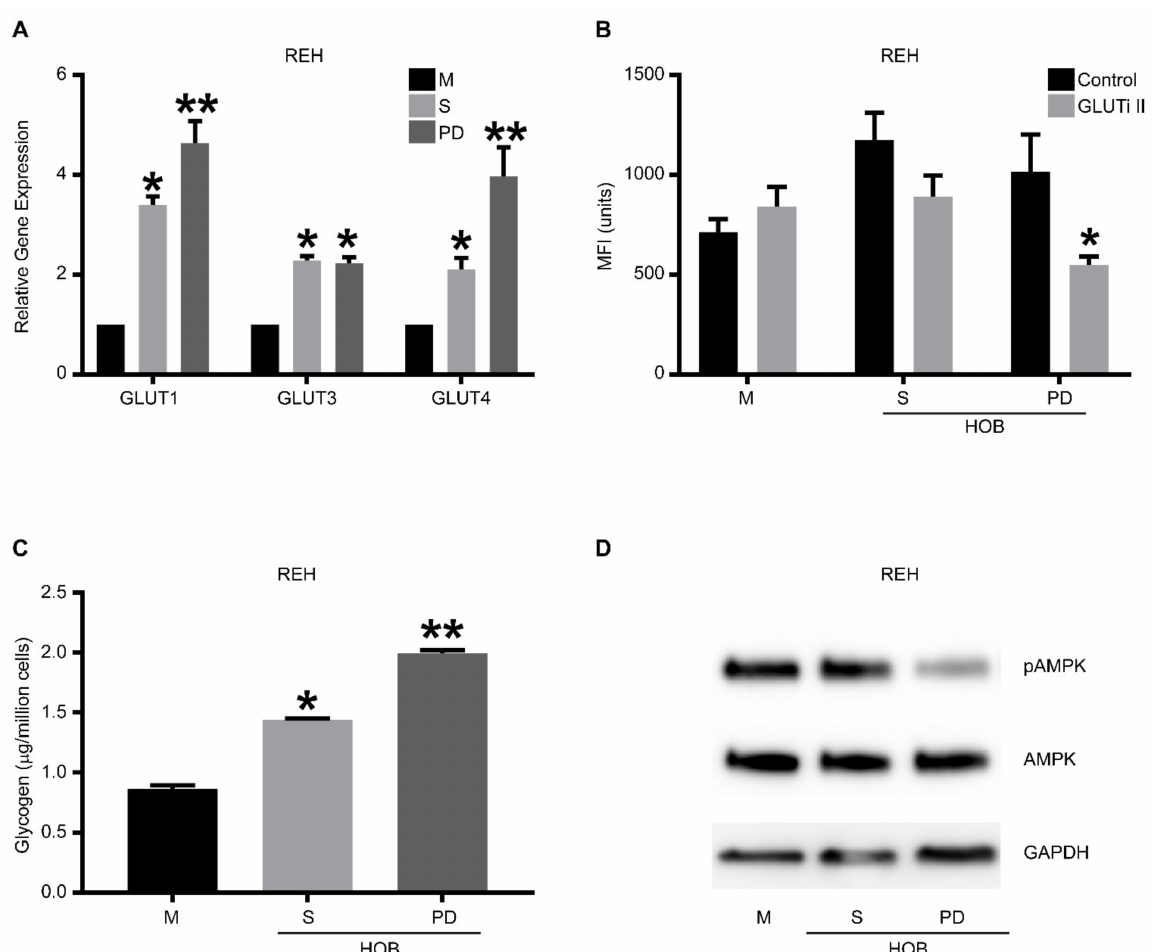
Figure 2. Drug-resistant phase dim (PD) cells are characterized by anabolic metabolism. REH cells were co-cultured with HOB, and the tumor cells in suspension (S) and the phase dim (PD) cells were isolated and compared to REH cells grown in media alone (M). ( A ) RT-PCR was used to determine the expression levels of GLUT-1, 3, and 4. Data is represented as mean ± SEM and is a representative of an experiment performed in triplicate at least two independent times. ( B ) The different cell populations were treated with a pan GLUT inhibitor (GLUTi II) or vehicle control followed by incubation with 2-NBDG. Flow cytometry was used to measure glucose content in cells shown as mean fluorescent intensity (MFI). ( C ) A glycogen colorimetric assay was used to measure the glycogen content in the isolated tumor cell populations. ( D ) Western blot analysis was used to measure the amount of AMPK and phospho-AMPK. The blots are representative of three independent experiments. * p < 0.05 when compared to cells grown in media alone. ** p < 0.05 when compared to suspension cells isolated from co-culture or tumor cells grown in media alone. The uncropped blots are shown in Supplementary